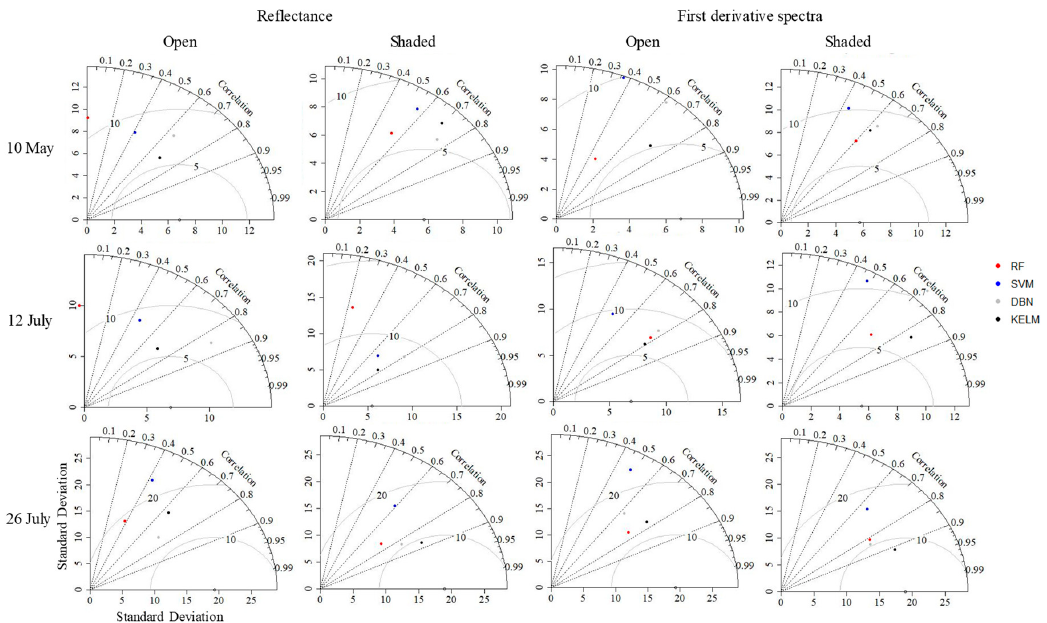
Figure 7. Taylor diagrams showing the performance of regression models for each treatment (open or